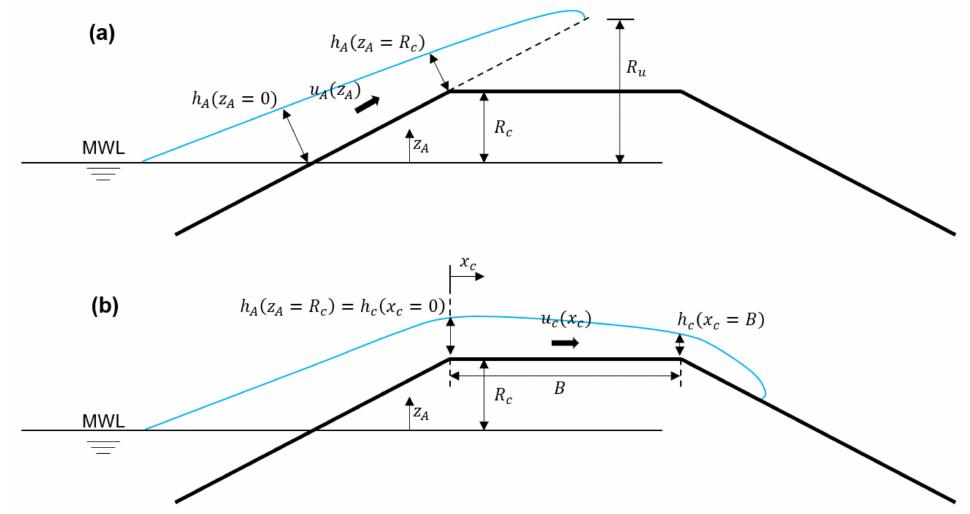
Figure 1. Definition sketch of fictitious wave run-up ( a ) and wave overtopping ( b ). The wave run-up and wave overtopping parameters are based on Schüttrumpf and van Gent